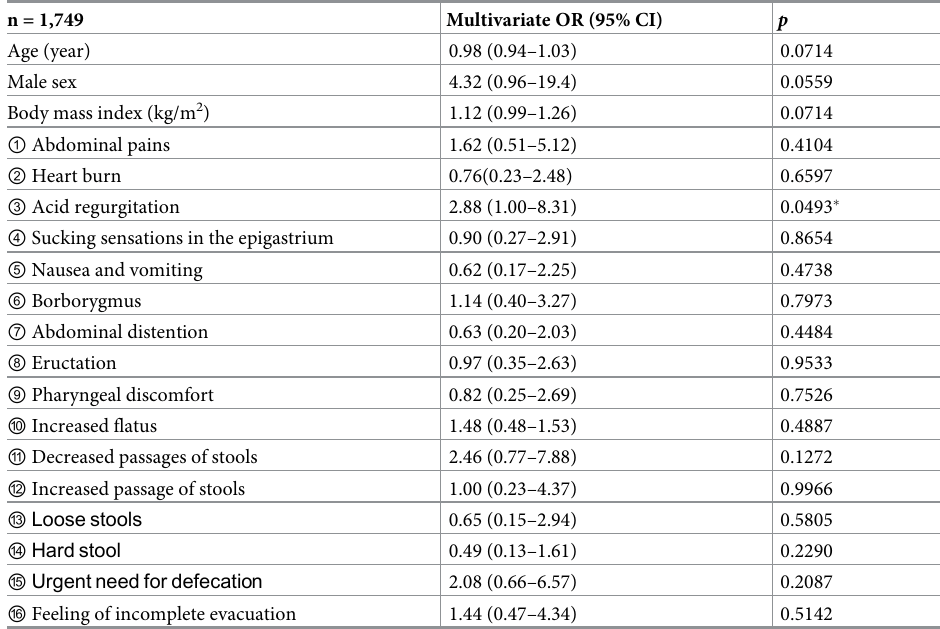
Table 3. Associated factors for severe GERD of non-DM